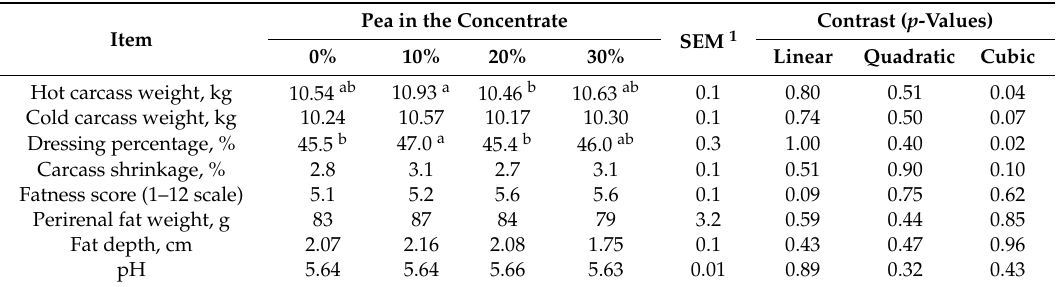
Table 6. E ff ect of the inclusion of pea in the concentrate on carcass characteristics and pH of the longissimus thoracis muscle (performance